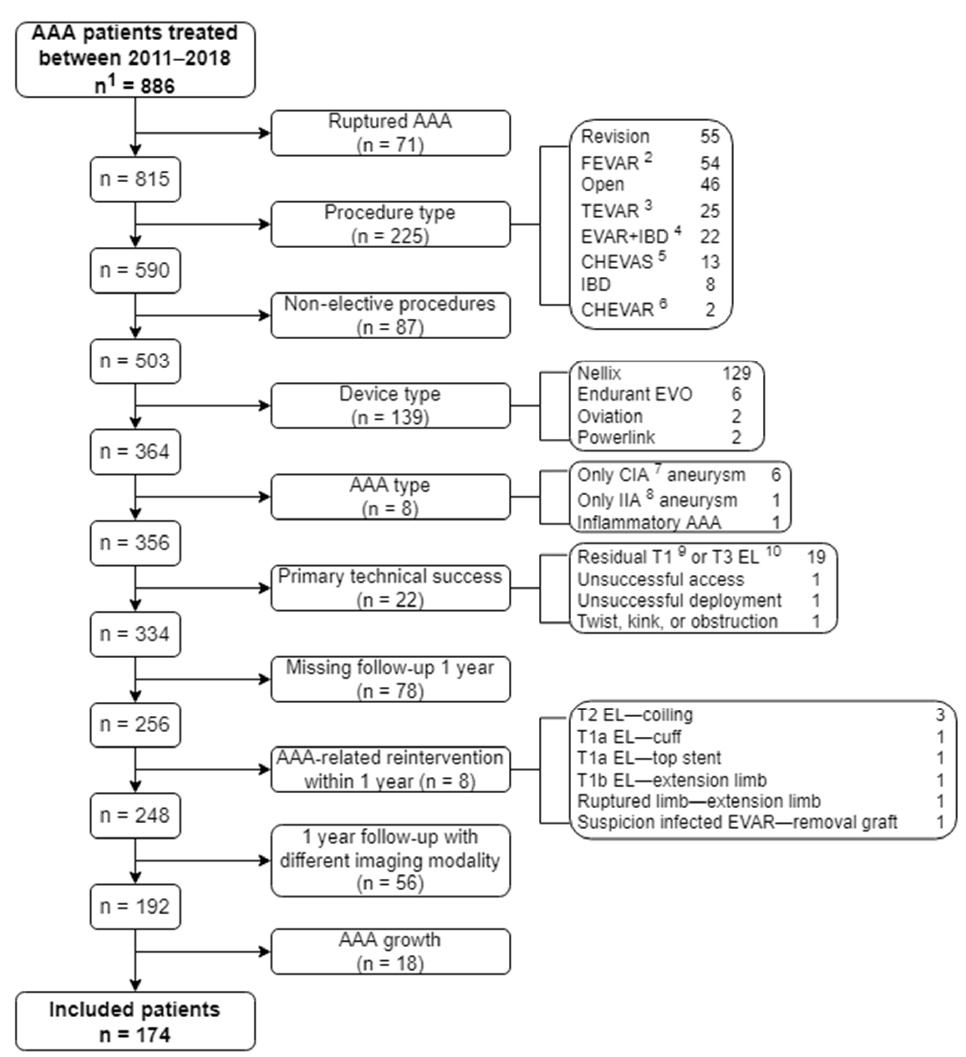
Figure 1. Flowchart of patient selection. 1 n = number of patients, 2 FEVAR = fenestrated EVAR, 3 TEVAR = thoracic EVAR, 4 IBD = iliac branched device, 5 CHEVAS = chimney endovascular sealing, 6 CHEVAR = chimney EVAR, 7 CIA = common iliac artery, 8 IIA = internal iliac artery, 9 T = type, 10 EL = endoleak.